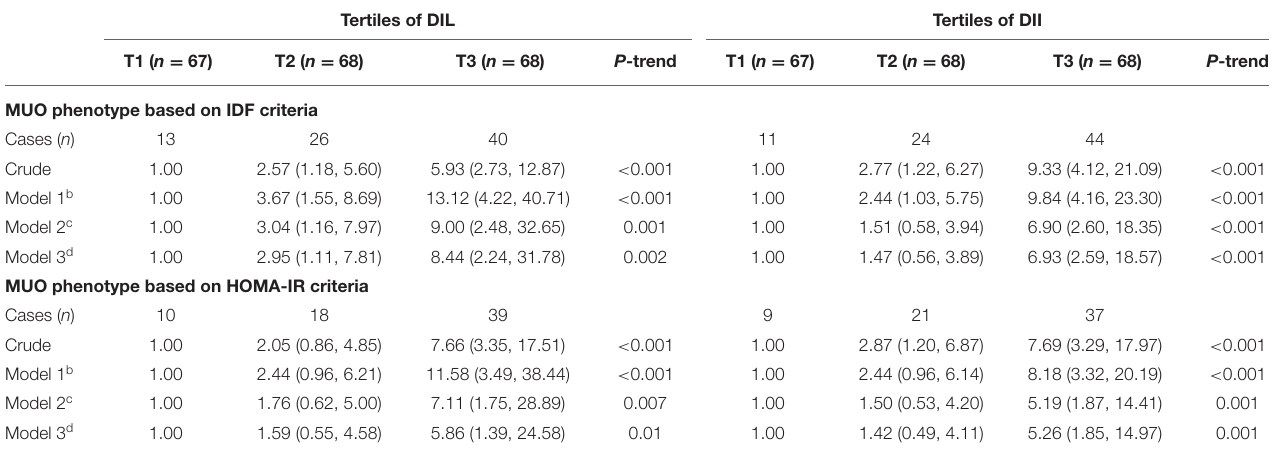
TABLE 3 | Multivariate adjusted odds ratio (OR) and 95% CI for MUO across tertiles of DIL and DII a . Tertiles of DIL Tertiles of